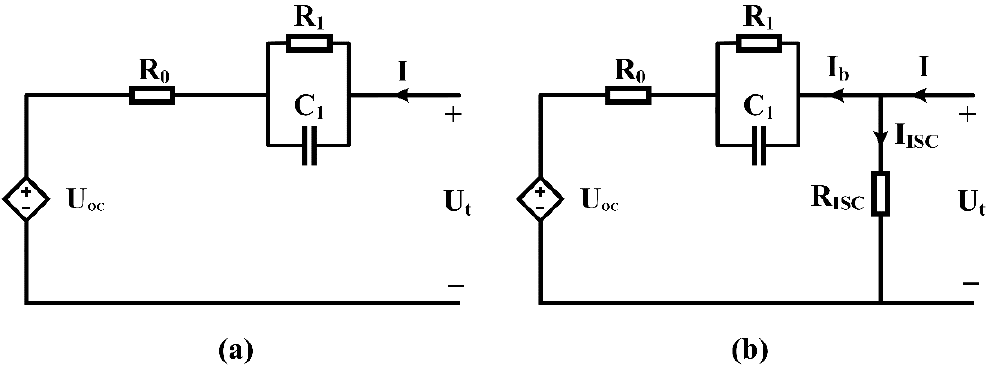
Figure 1. ECMs for: ( a ) Normal batteries; ( b ) ISC batteries.